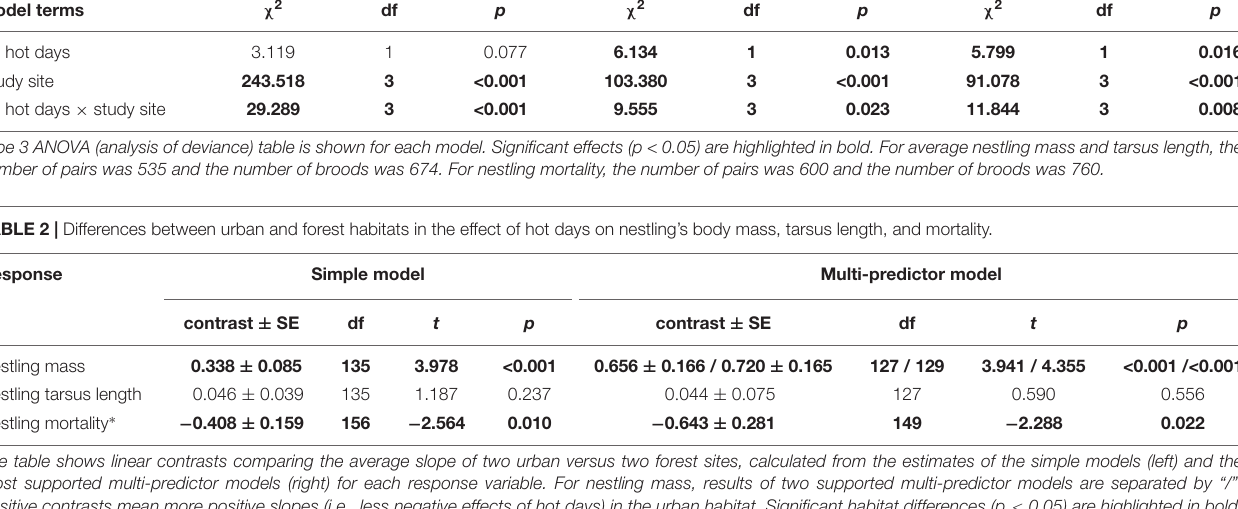
TABLE 1 | Relationship between the number of hot days during nestling development and nestlings’ body mass, tarsus length, and mortality, according to the simple models. Nestling mass